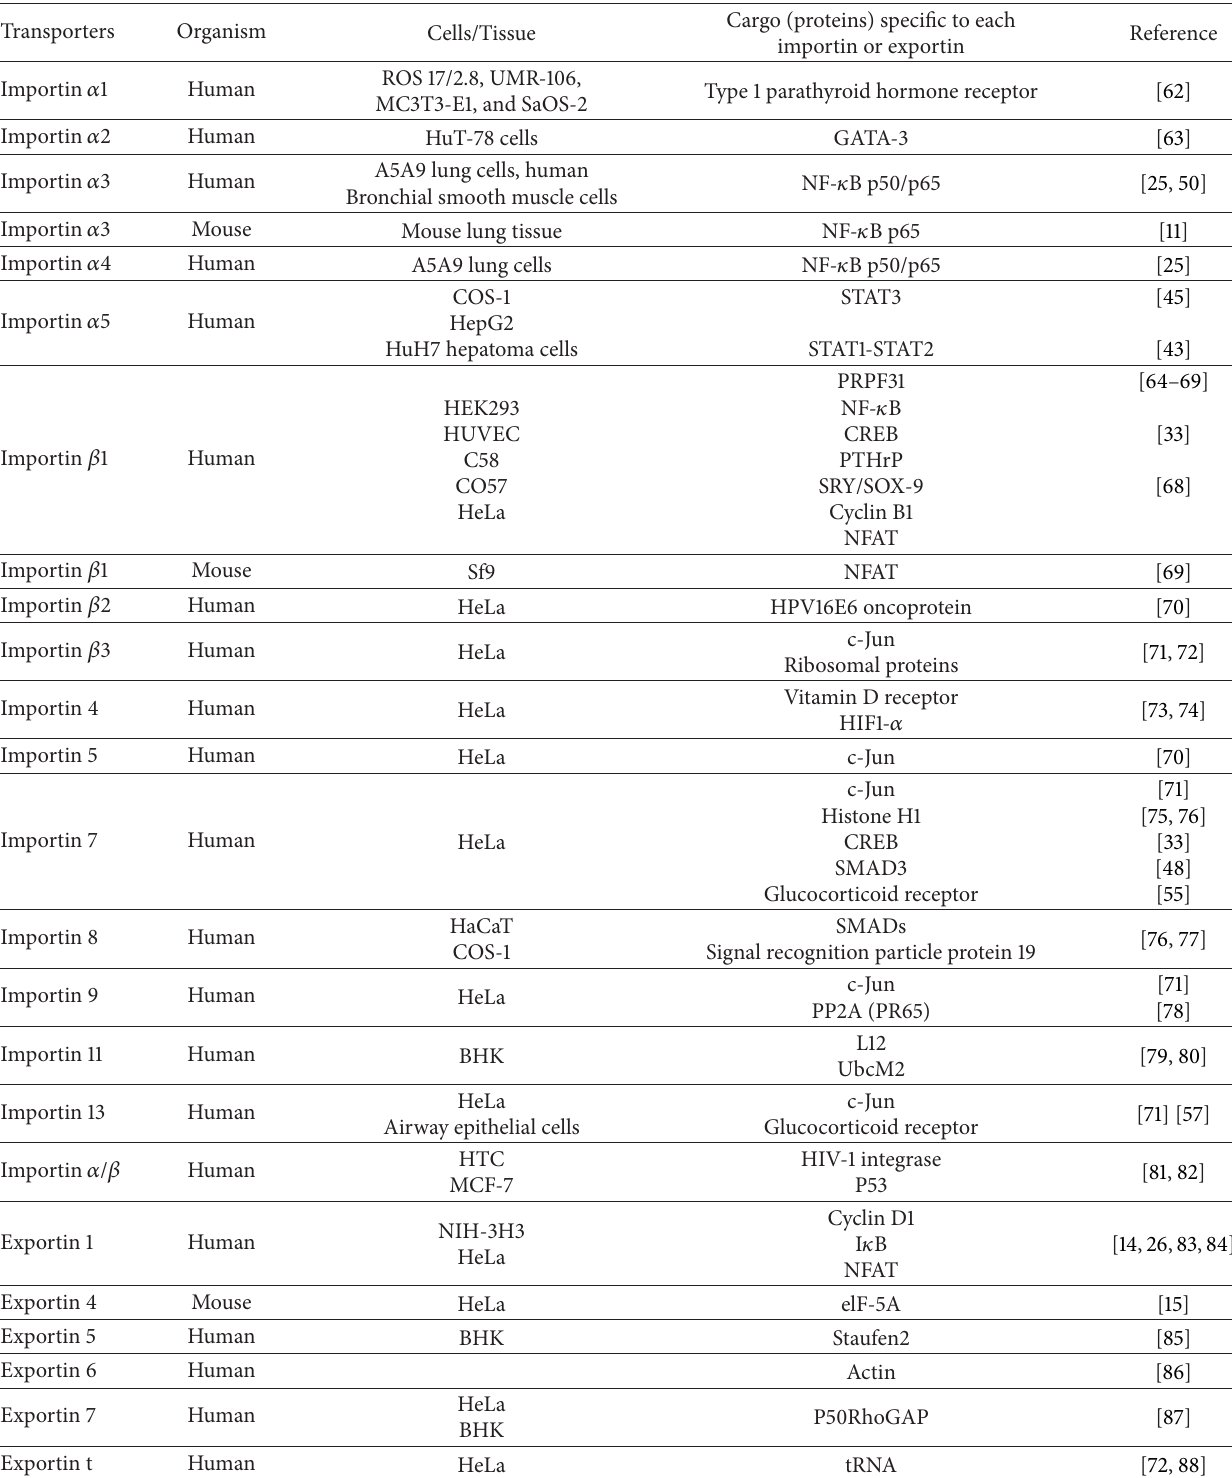
Table 2: Specificity of different classes of importins/exportins in transporting cargo to and from the